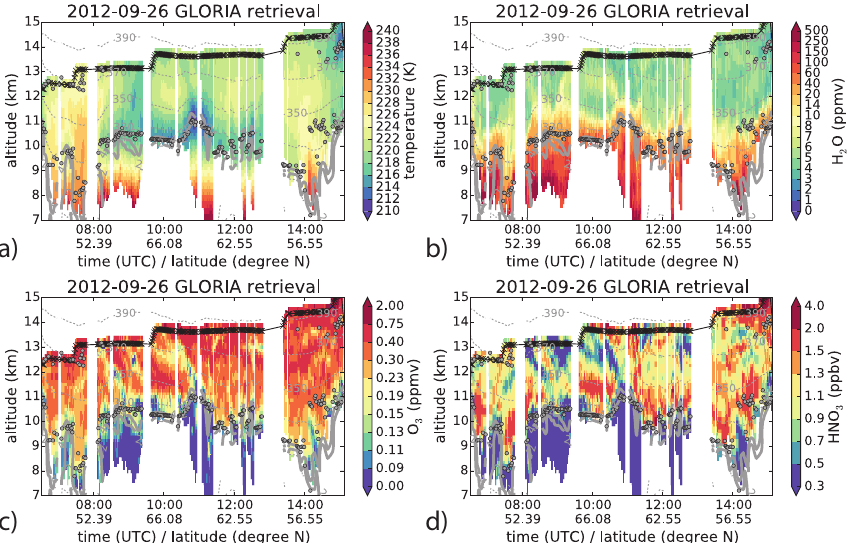
Figure 6. Cross-sections of retrieved quantities for the flight of 26 September 2012: temperature (a) , H 2 O (b) , O 3 (c) , and HNO 3 (d) . In addition, selected isentropes are shown as dotted grey lines, ECMWF potential vorticity (interpolated to the time of measurement) isolines of 2 and 4PVU are shown as thick grey lines. The thermal tropopause is derived from retrieved temperature profiles and is shown as thick grey dots. Depicted retrieved values are limited below by clouds and above by the flight